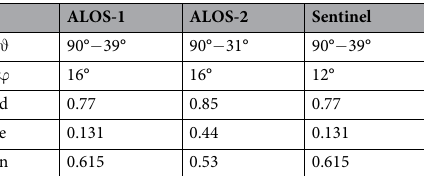
Table 2. Corrections used for projection of in-situ data on satellites